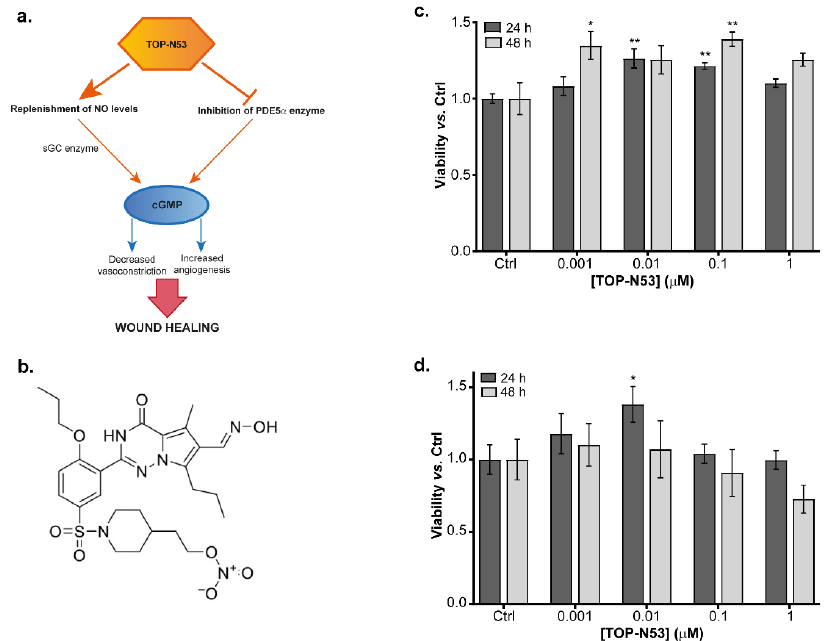
Figure 1. Effect of TOP-N53 in primary skin cells. ( a ) Dual mechanism of action of TOP-N53 acting as NO-donor and PDE5 inhibitor increasing cGMP levels to promote wound healing. ( b ) Chemical formula of TOP-N53. ( c ) Viability assay of primary NHF and ( d ) NHK with increasing concentrations of TOP-N53 at 24 h and 48 h. Data represented as mean ± s.e. ( n = 3). * p ≤ 0.05 and ** p ≤ 0.01 using one-way ANOVA with a Dunnet test post-hoc